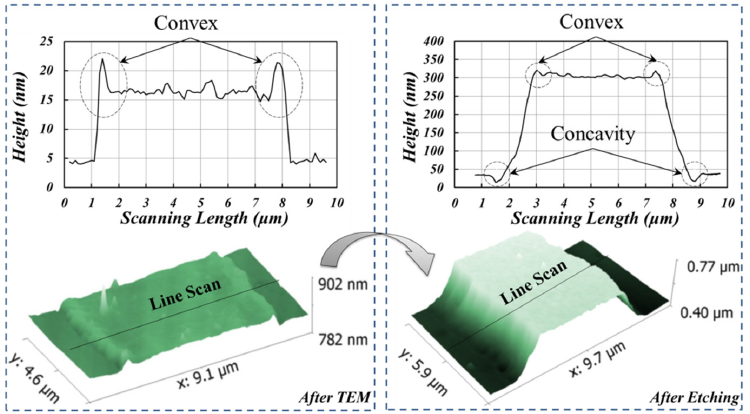
Figure 8. Atomic force microscopy images of the TEM etching process. TEM with 350 °C, 1000 V, and etching for 10 min.